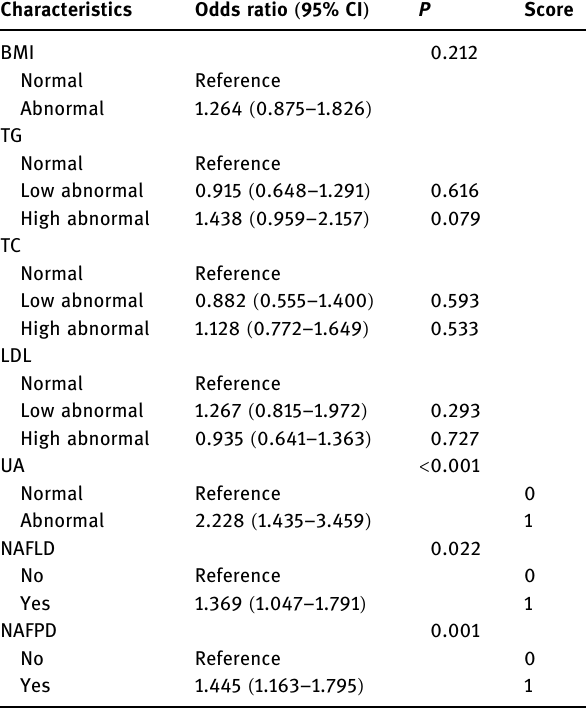
Table 2: Univariate analysis of factors associated with breast cancer Characteristics